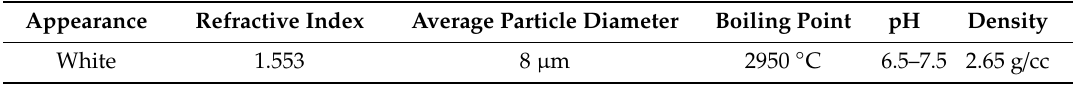
Table 2. Technical characteristics of silicon dioxide.